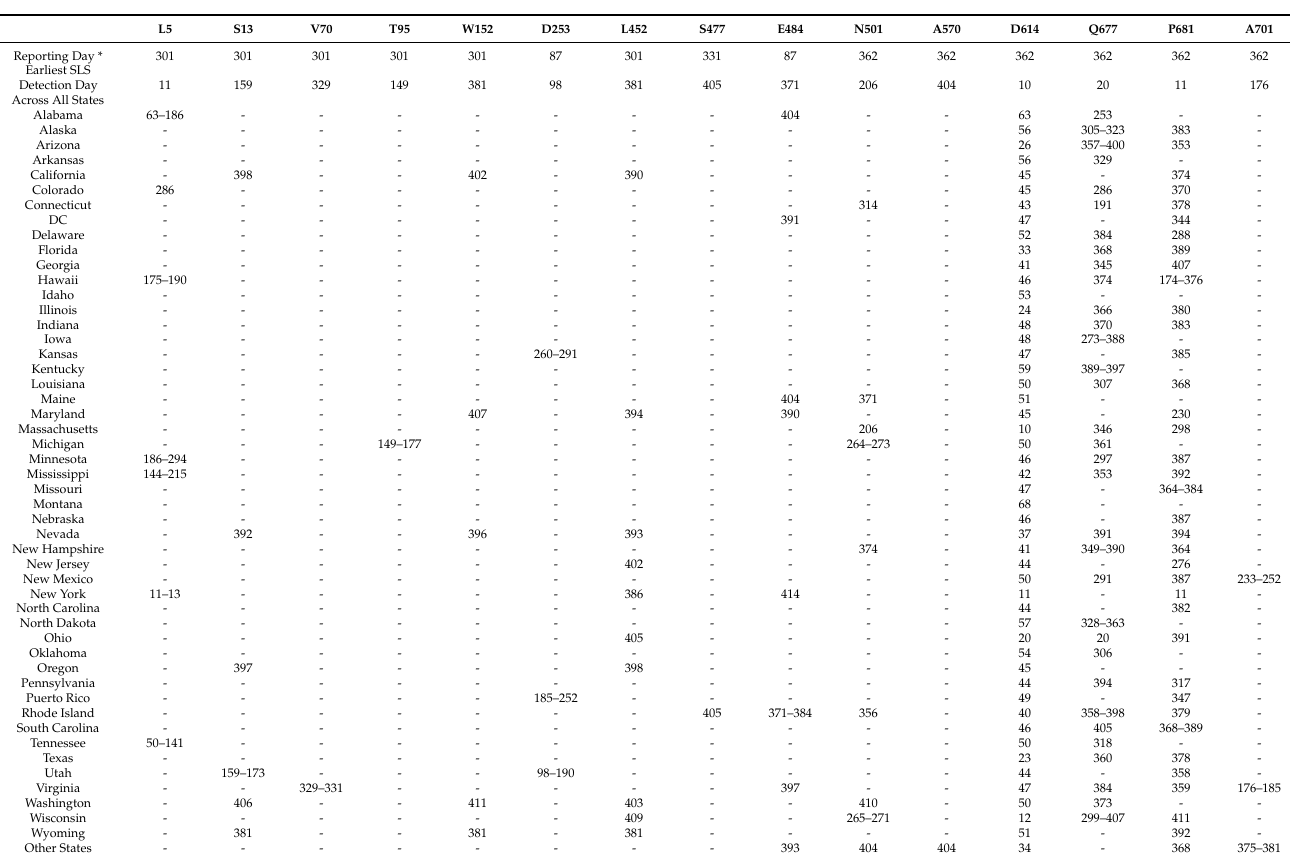
Figure 2, for example, shows the results of the unsupervised case and VRV clustering for Washington state. The heatmap shows that multiple VRVs tend to aggregate among subsets of cases, the inspection of which can reveal VRV-haplotypes. For example, the case cluster “PG7”, which included 208 cases, had VRVs from the “RG4” and “RG3” clusters, which included the VRVs (G142-S155-F157-E180-K444-L452-T478-D614-Q677-P681-T732-T859- S940-D950) (see Table S5). Table 1. Comparison by state/territory of the time to detect an emerging VRV by the SLS method vs. the first reported appearance of the